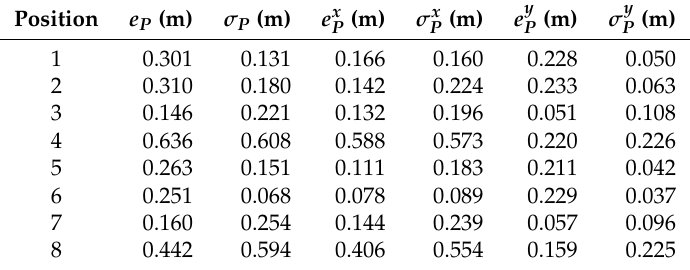
Table 1. Measured accuracy of the PSO algorithm in Scenario